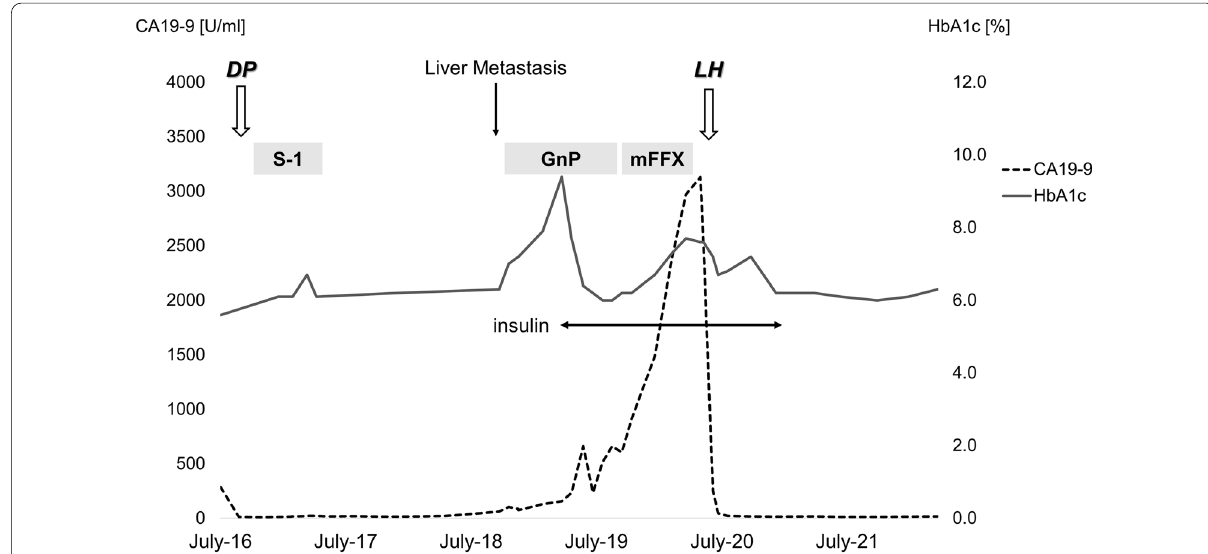
Fig. 4 Summary of patient’s clinical course. DP distal pancreatectomy, LH left hepatectomy, GnP gemcitabine and nab-paclitaxel, mFFX modified FOLFIRINOX, LM liver metastasis, CA19-9 carbohydrate antigen